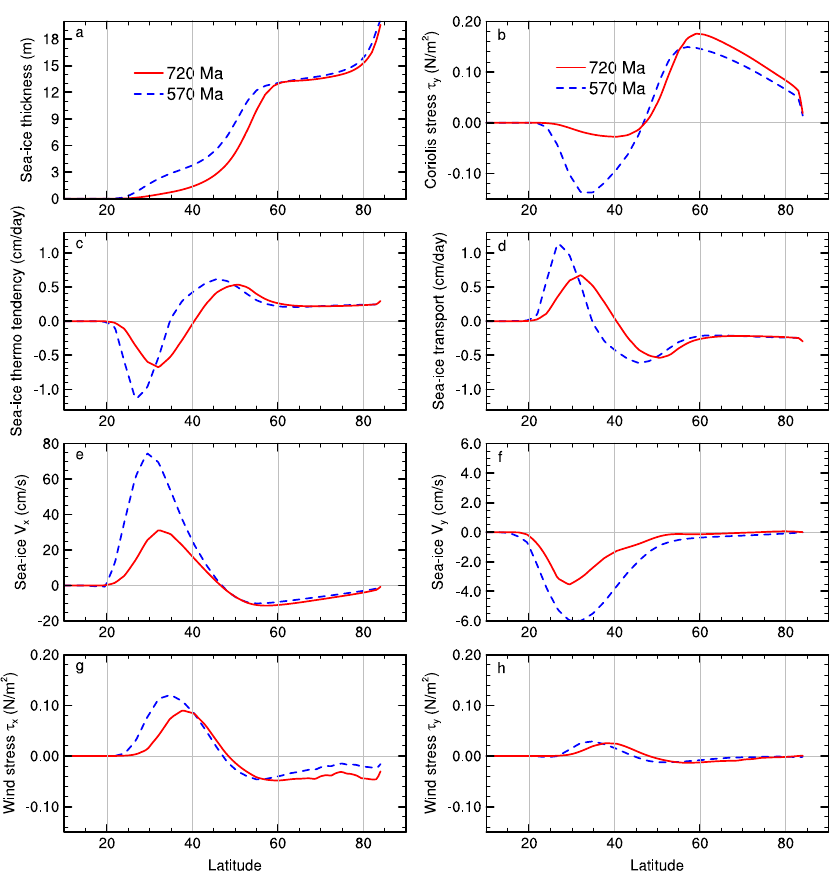
Fig. 13. The 100yr mean (a) ice thickness, (b) meridional Coriolis stress, (c) sea-ice mass change due to thermal effect, (d) sea-ice mass change due to transport, (e) sea-ice zonal velocity, (f) sea-ice meridional velocity, (g) zonal wind stress and (h) meridional wind stress. The zonal mean includes only the portion from longitude 90 ◦ W to 30 ◦ E, to exclude the land portion of the 720Ma continental configuration. The velocities are positive east or north. TSI = 0.94TSI 0 , τ = 0 . 12, p CO 2 = 140 ppmv for both two